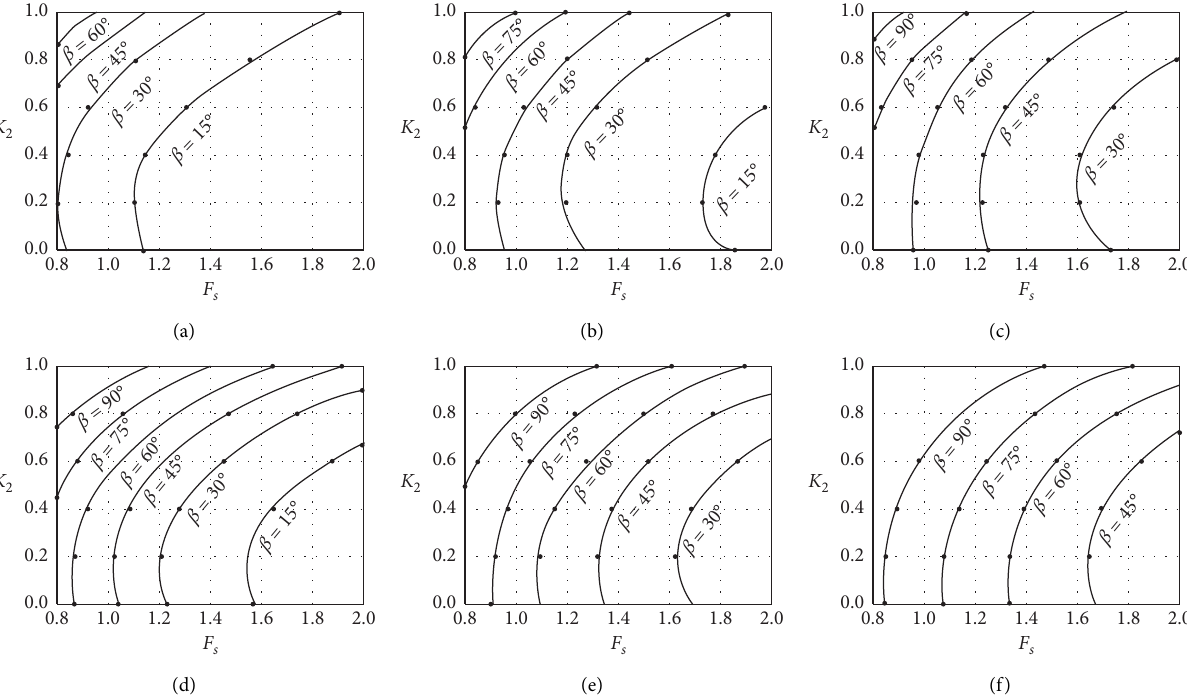
Figure 6: Factor of safety charts for different static water levels: (a) c / H (d) c / H 1 � 2.0, φ � 10 ° ; (e) c / H 1 � 2.0, φ � 20 ° ; (f) c / H 1 � 2.0, φ � 30 °